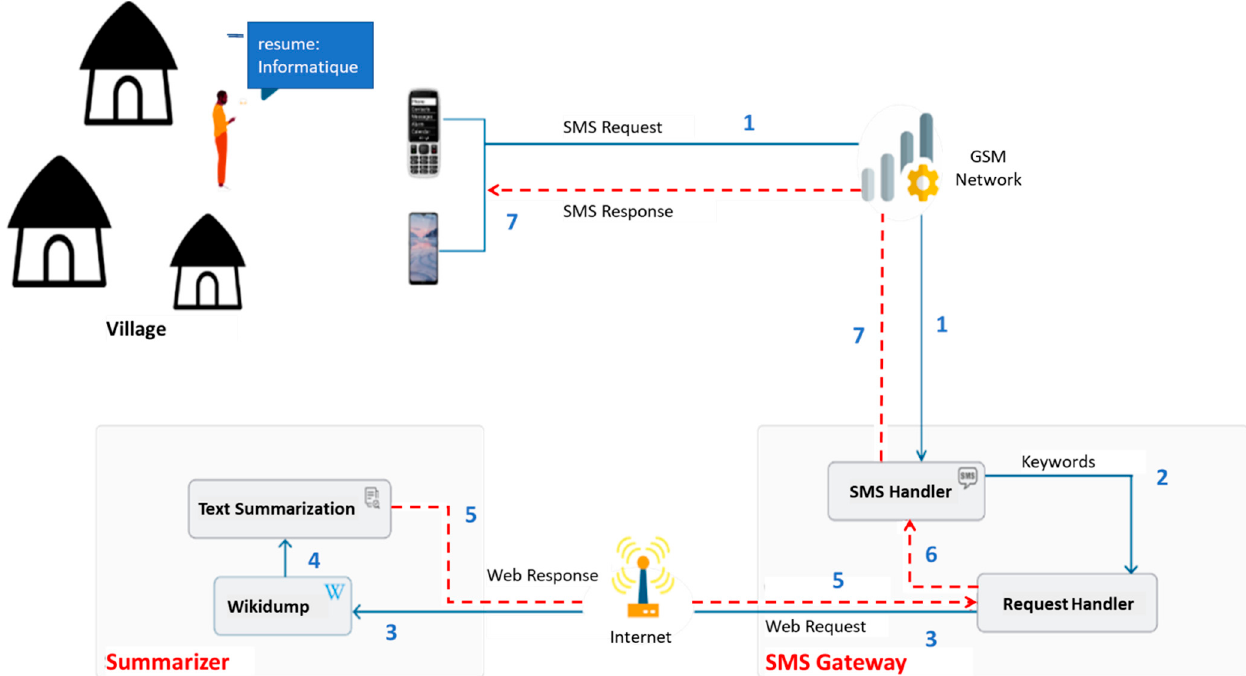
Figure 2 . WATS-SMS Architecture . Figure 2. WATS-SMS